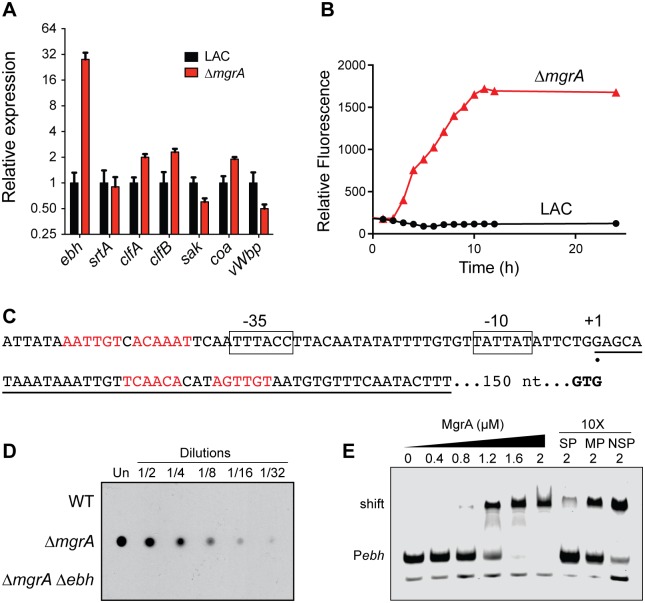
MgrA directly represses ebh.(A) Quantification of transcripts of genes related to clumping in LAC and the mgrA mutant using qRT-PCR. Values are averages and standard deviations of three biological replicates, normalized to expression in LAC for each gene. (B) Expression of ebh was measured in LAC and the mgrA mutant using a transcriptional fusion of the entire intergenic region upstream of ebh to GFP. (C) The putative ebh transcription start site, indicated by the black circle, was determined by 5’ RACE. Possible -10 and -35 promoter elements are boxed, and the ebh start codon (GTG) is shown in bold. Potential MgrA binding sites are shown in red text, and the sequence of the DNA probe used for EMSA experiments is underlined. (D) Ebh protein levels were measured by dot blot in 2-fold dilutions of supernatants from overnight cultures of the indicated strains. All strains also lacked the spa gene. (E) EMSA showing MgrA binding to the ebh promoter. Increasing concentrations of MgrA were incubated with an IRDye-labeled probe (Pebh, sequence underlined in C) before separation by PAGE. Unbound probe (Pebh) and MgrA-probe complex (shift) are indicated. The last three lanes show competition experiments, where the binding reaction included a 10-fold excess of unlabeled specific probe (SP), non-specific probe (NSP), or a version of the specific probe in which the proposed MgrA binding site was mutated (MP).